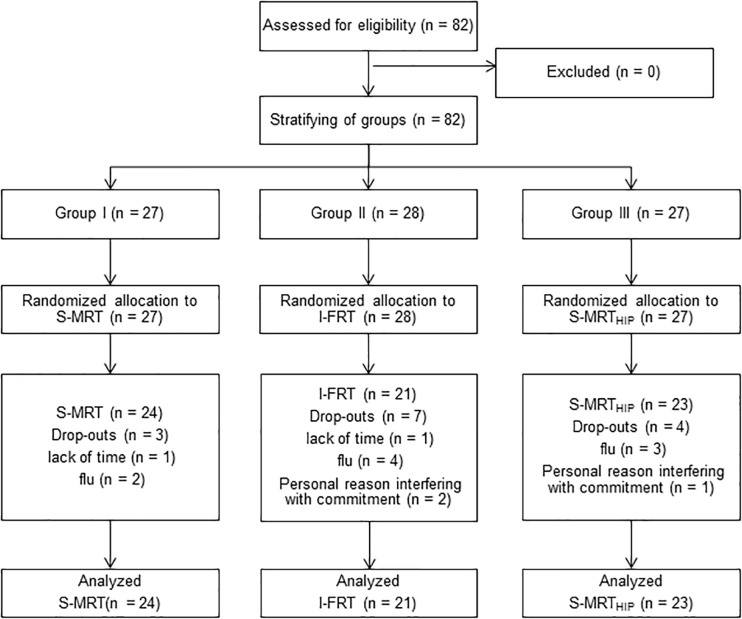
CONSORT diagram with participant flow. S-MRT, stable machine-based resistance training; I-FRT, instability free-weight resistance training; S-MRTHIP, stable machine-based adductor/abductor resistance training.